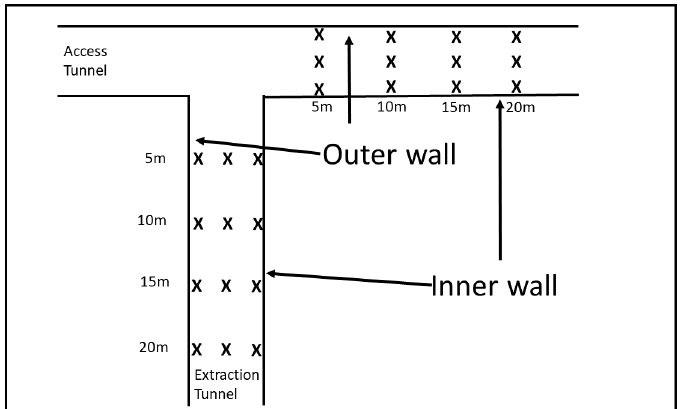
Figure 12. Tunnel junction